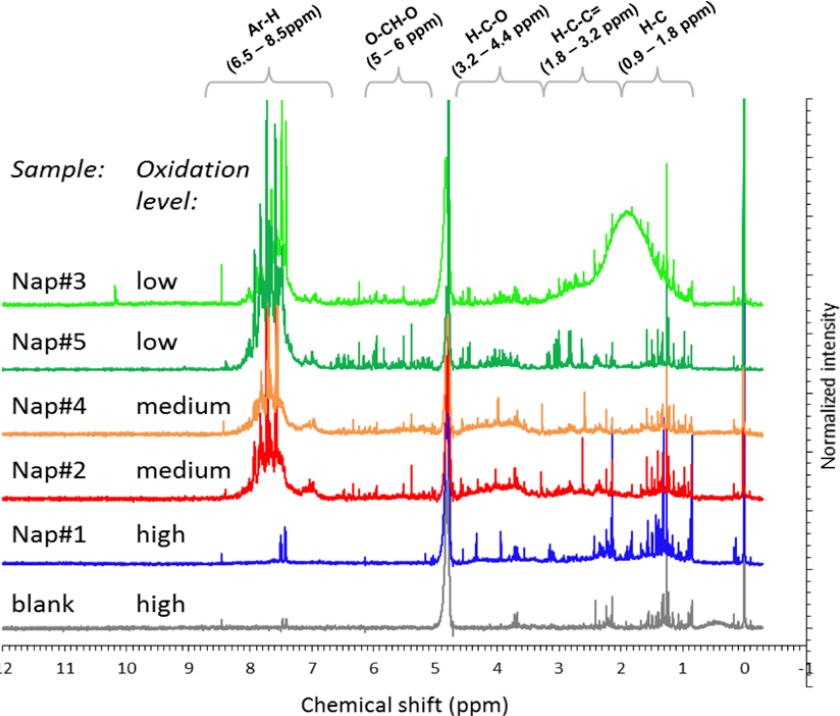
Figure 2. 1 H-NMR spectra of naphthalene SOA as a function of increasing photochemical age in the PAM reactor. The sharp singlet at 0ppm represents the internal standard (TSP- d 4 ), while the broad peak at 4.8ppm is the – partly instrumentally suppressed – HDO